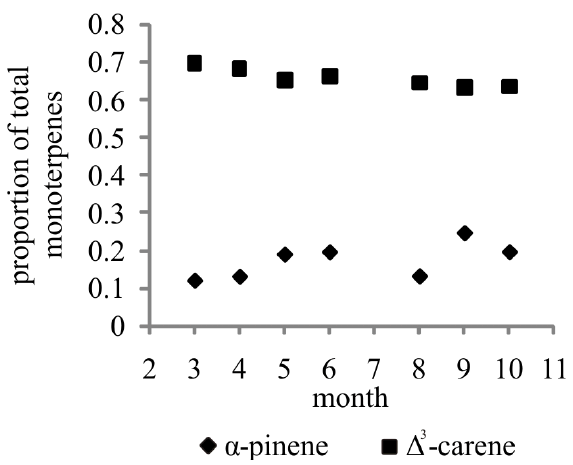
Fig. 4. Variation in proportions (from total monoterpenes) of a-pinene and 1 3 -carene in emissions of one tree ( 1 3 -carene - chemotype) over one year (2003). Monthly average values ( n =1 to 10), data from Tarvainen et al.